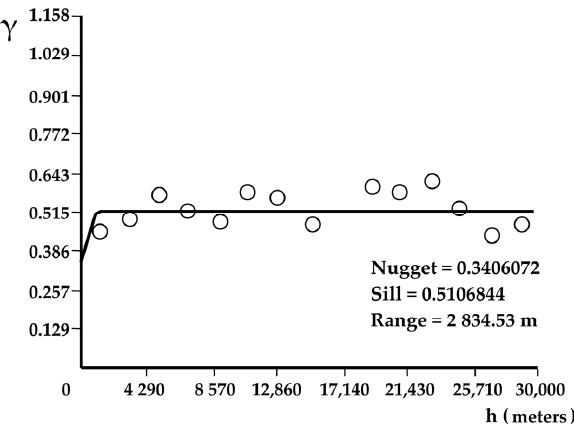
Figure 3. Semi-variogram of active acidity (pH).